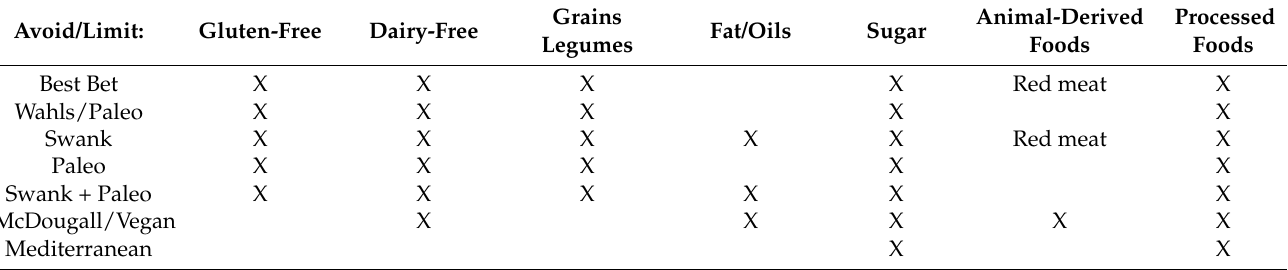
Table 1. Diet patterns found on MS social media sites and foods that are